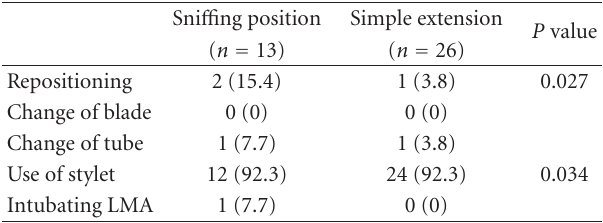
Table 6: Alternate techniques used.